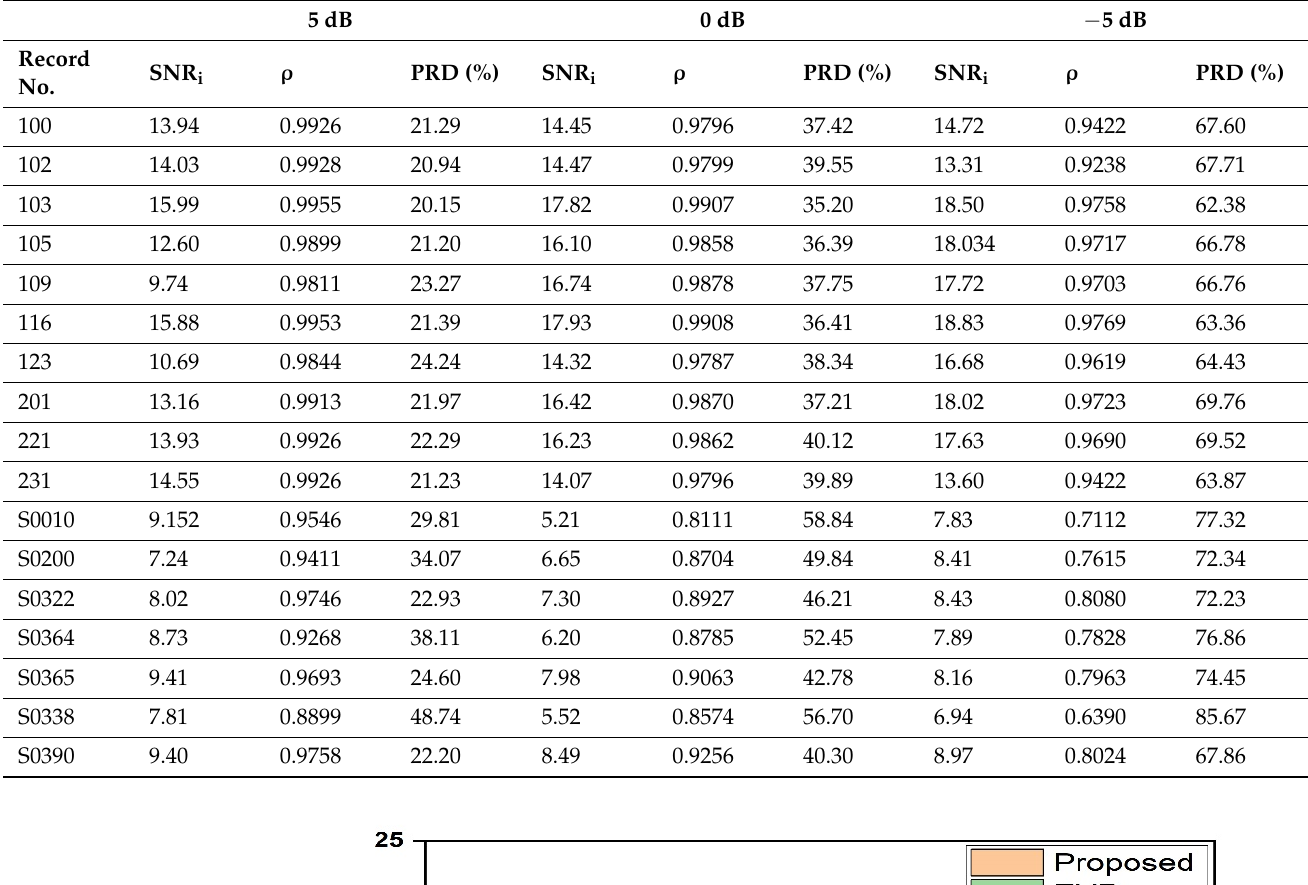
Table 6. Improvement in SNR, cross-correlation and PRD values between the denoised signal and the clean input signal in presence of baseline wander at various input SNR value.